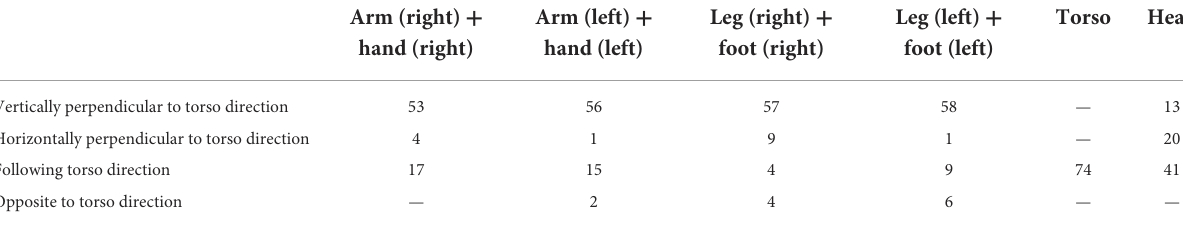
Arm (right) + hand (right)